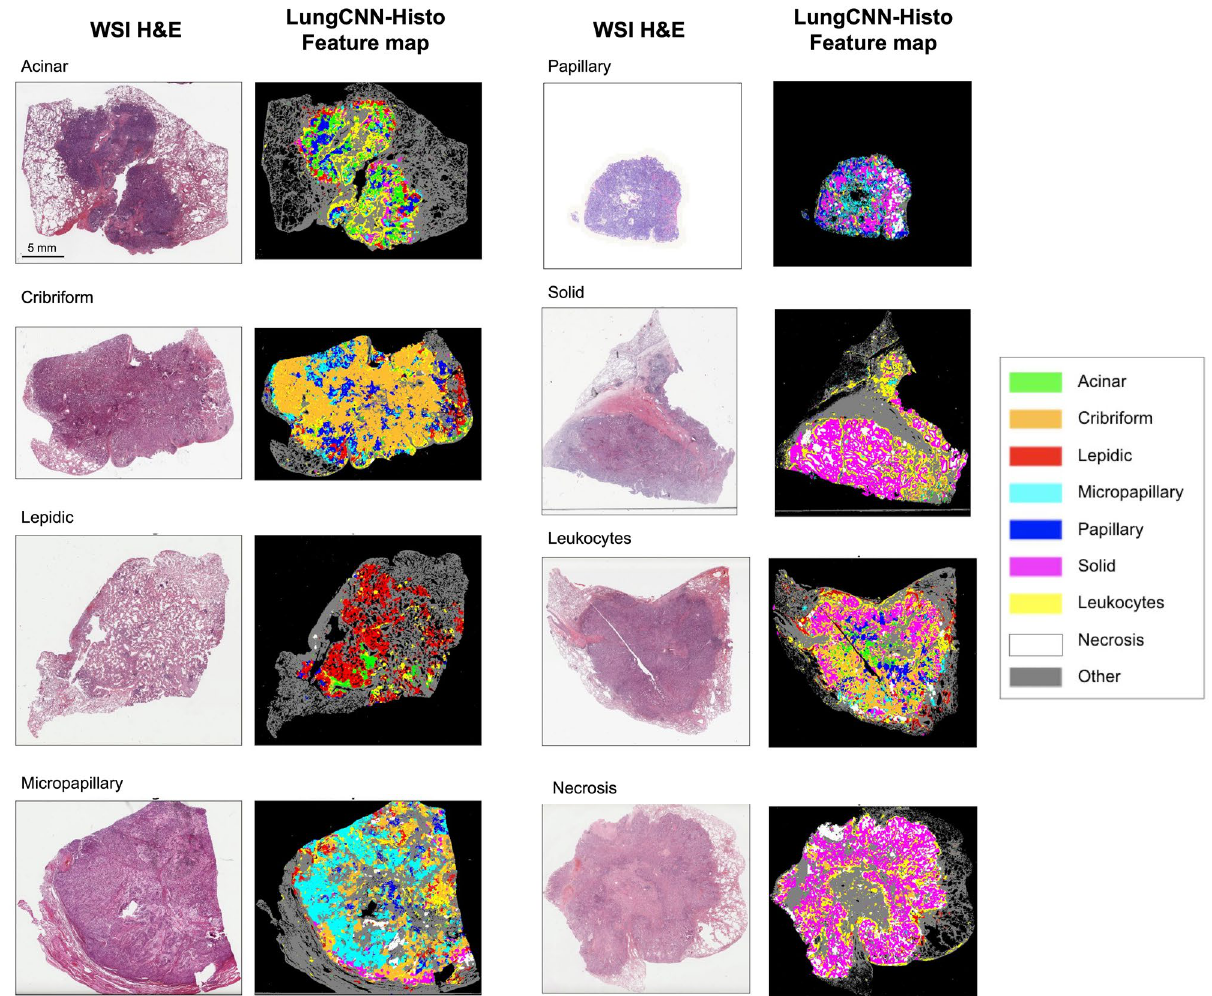
Figure 2. Visualization of LungCNN-Histo predictions for whole slide images. Shown are representative whole slide images with examples of each of the feature classes. WSI whole slide image, H&E hematoxylin and